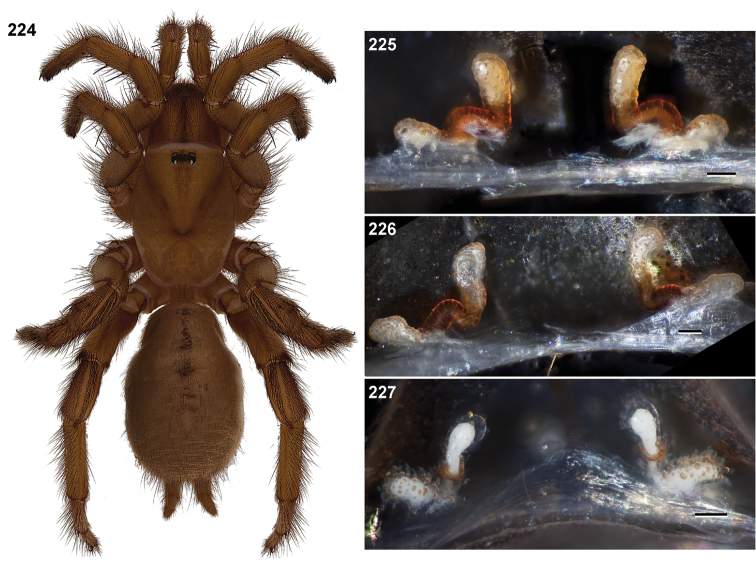
Aptostichus aguacaliente sp. n. female specimens. 224 paratype (AP393) habitus [805972] 225–227 cleared spermathecae of specimens from the type locality, Windy Point, Riverside Co. (AP393, 230, MY2508) [806704, 806614, 806617]; scale bars = 0.1mm.